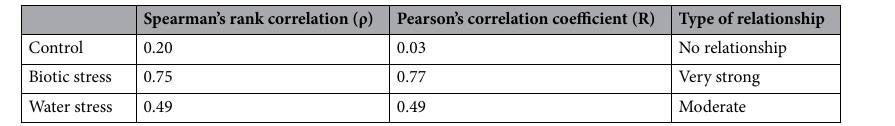
Table 10. Spearman’s Rank Correlation test and Pearson’s Correlation test show a significant relationship between biophoton emission intensity on Leaf A and Leaf B stressed by biotic/physical impact. A moderately positive relationship in the case of water stress and no association in the control groups of Leaf A and Leaf B.